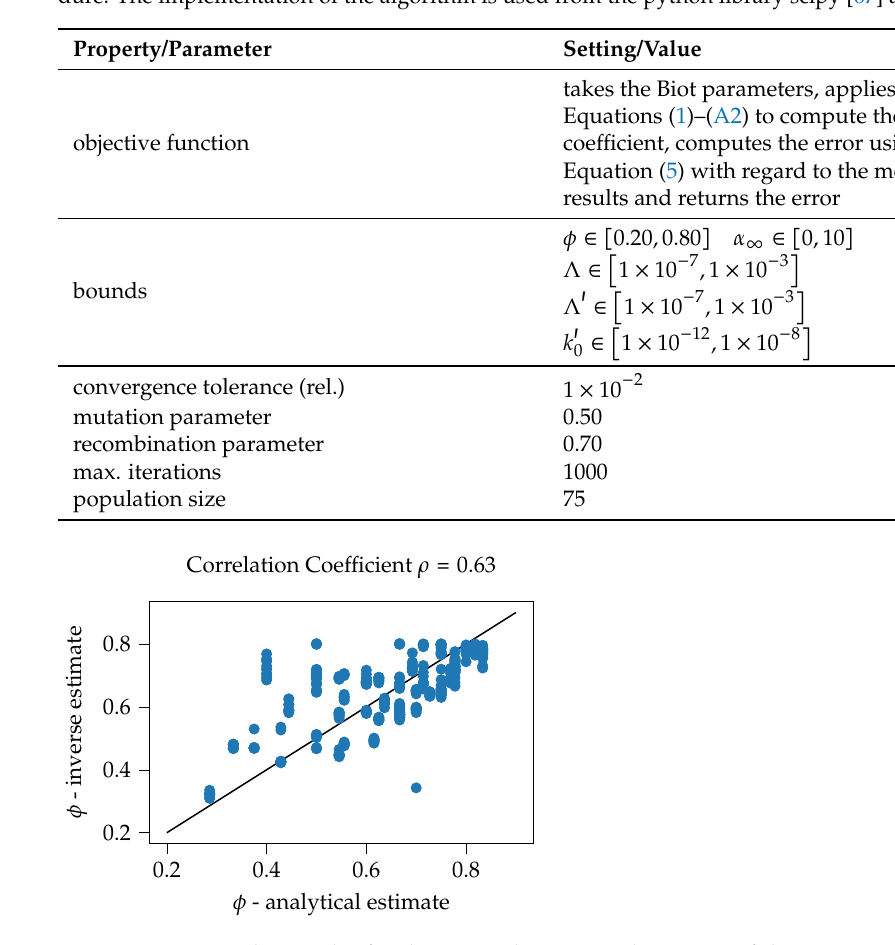
Figure A2. A correlation plot for the inversely estimated porosity of the specimen (vertical axis) and an analytical porosity estimate, computed using s